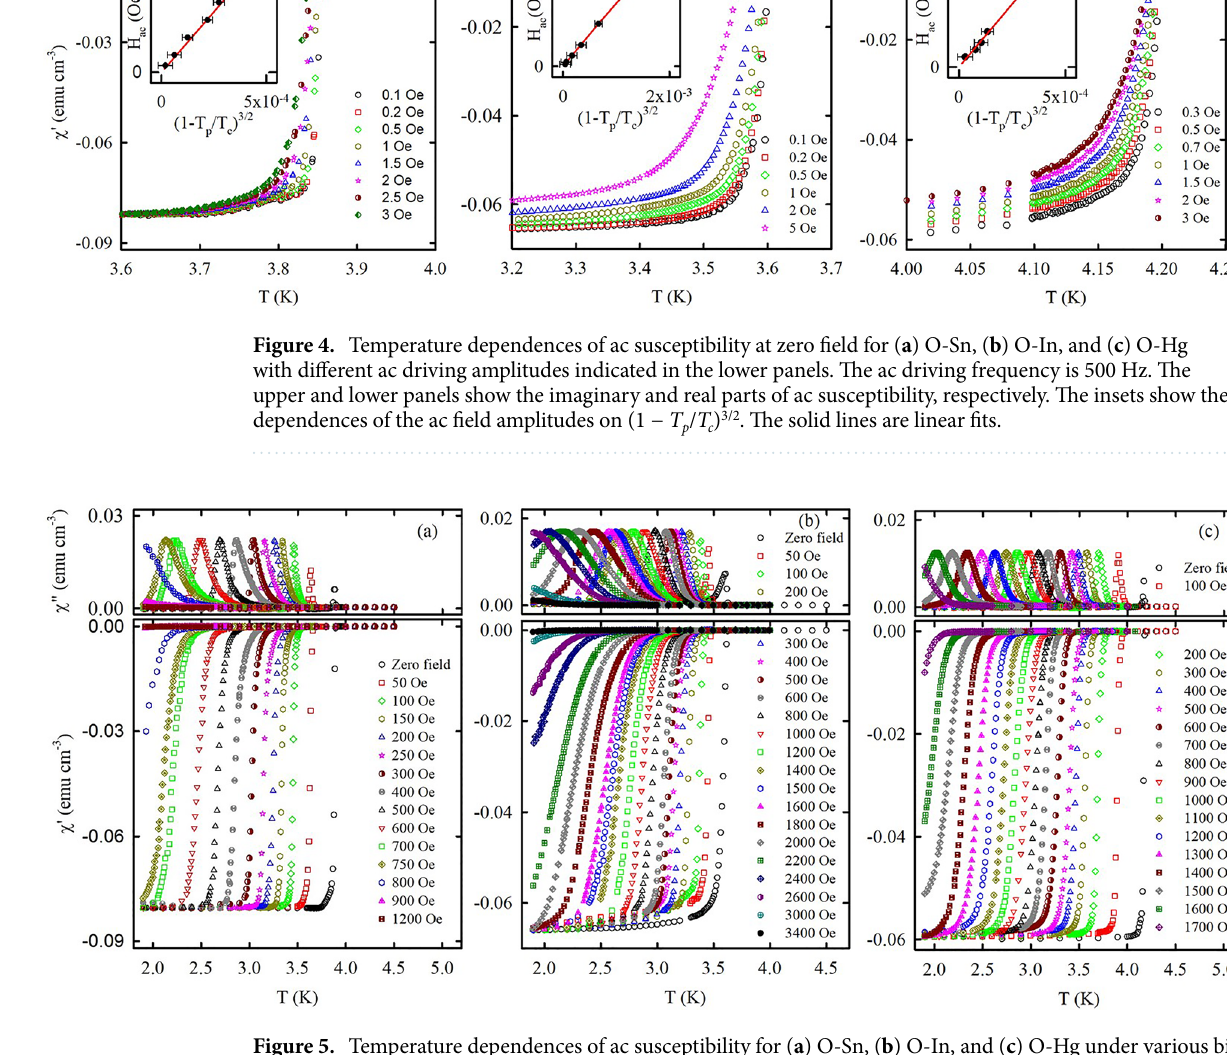
Figure 5. Temperature dependences of ac susceptibility for ( a ) O-Sn, ( b ) O-In, and ( c ) O-Hg under various bias magnetic fields indicated in the lower panels. The lower and upper panels show χ ′ and χ ″ , respectively. The ac frequency and ac field amplitude are 500 Hz and 1 Oe,